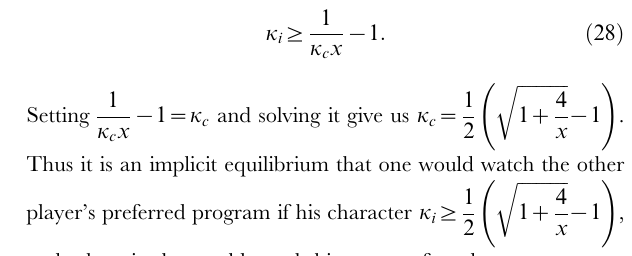
Table 5. The Battle of the Sexes Game.